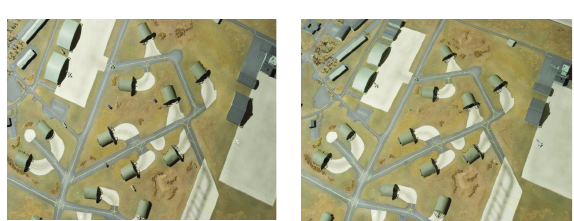
Figure 1: Sample images showing